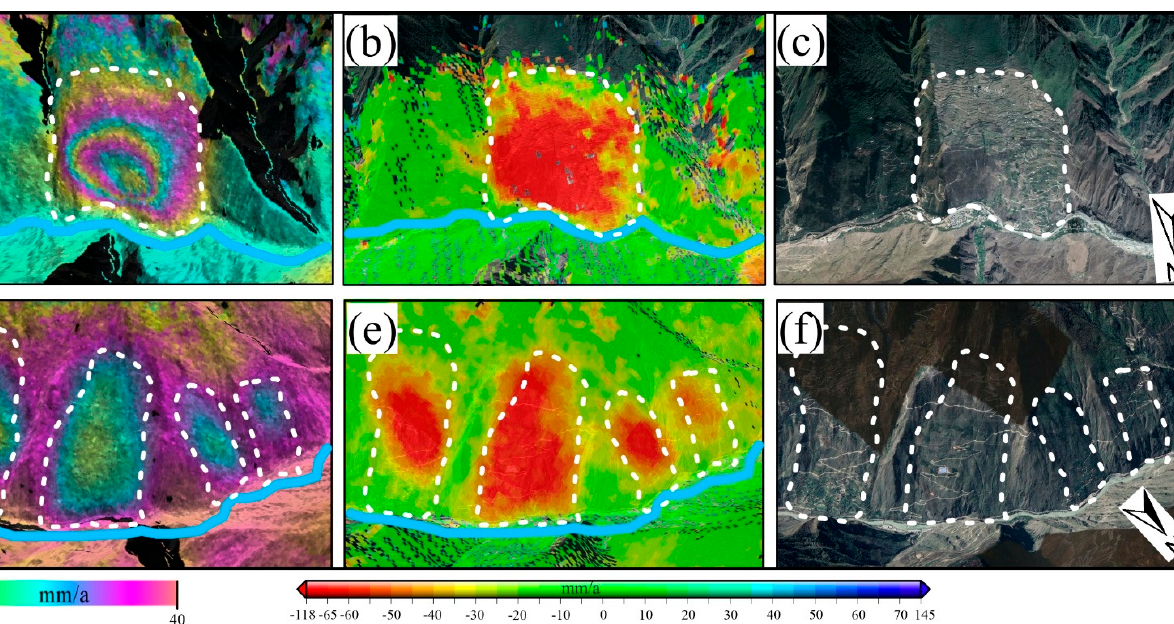
Figure 6. The potential landslides that can be identified by both methods. ( a - c ) Stacking-InSAR result, SBAS-InSAR result, Google Earth optical image of Taoping landslide, respectively; ( d - f ) Stacking-InSAR result, SBAS-InSAR result, Google Earth optical image of Taoping Township landslides group, respectively.